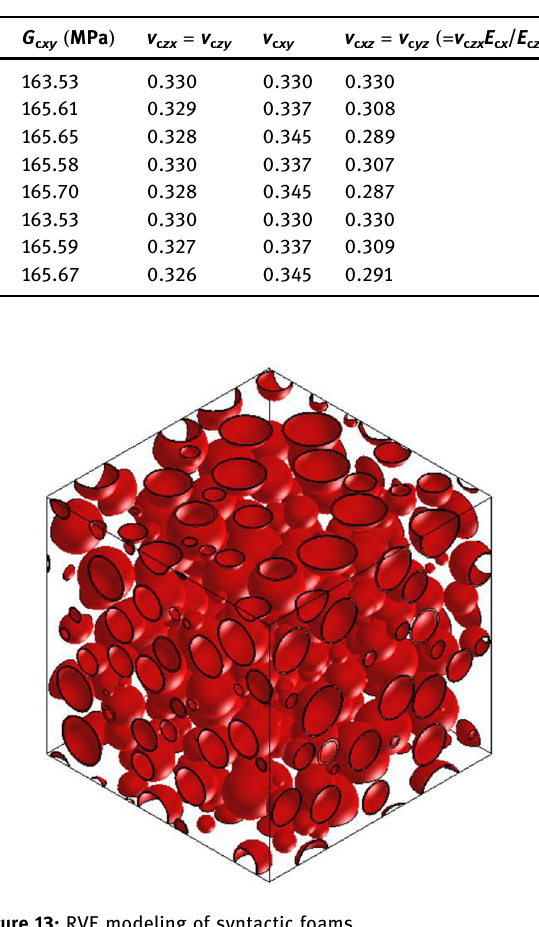
Figure 13: RVE modeling of syntactic foams.